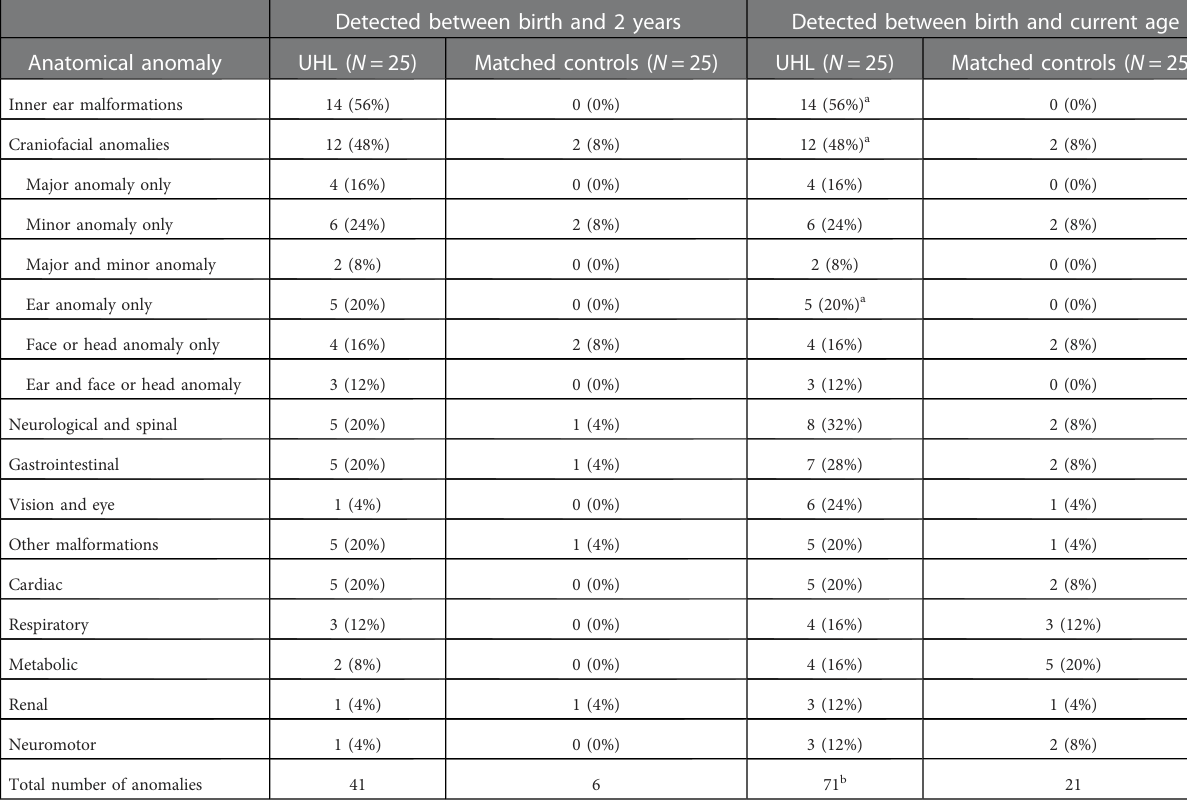
TABLE 2 Describing abnormal anatomical features detected between birth and 2 years.